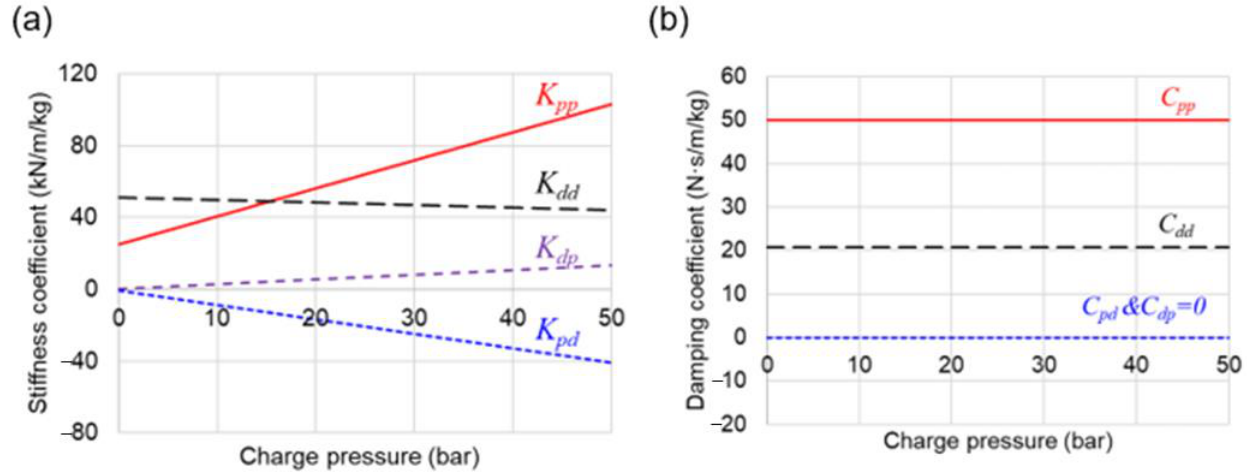
Figure 5. Predicted ( a ) system stiffness and ( b ) damping coefficients with charge pressure increasing from 0 to 50 bar for case 3.